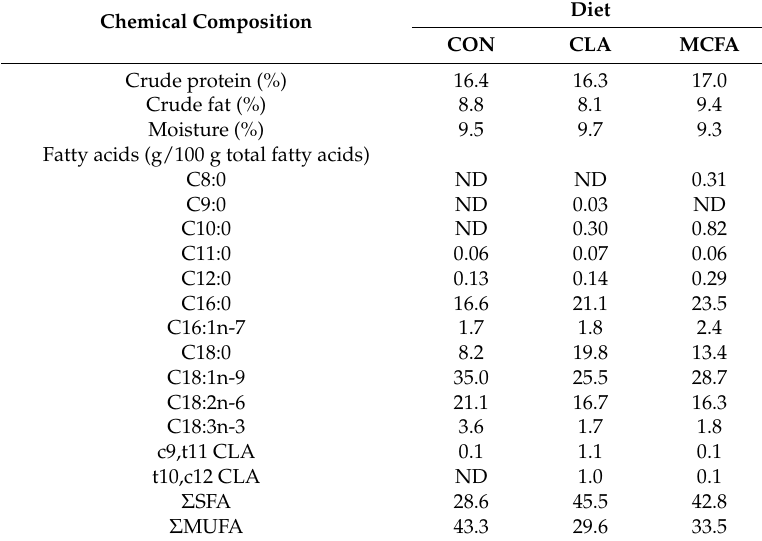
Table 2. Analyzed composition (dry matter basis) of experimental diets fed in late gestation and lactation. Chemical